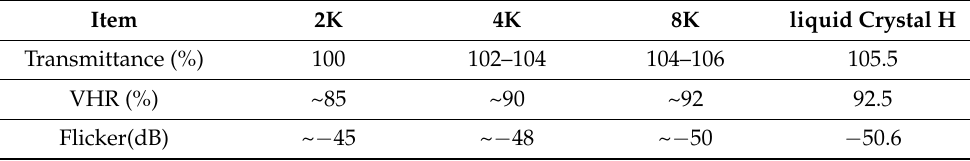
Table 8. The photoelectric properties of mixed liquid crystal H.